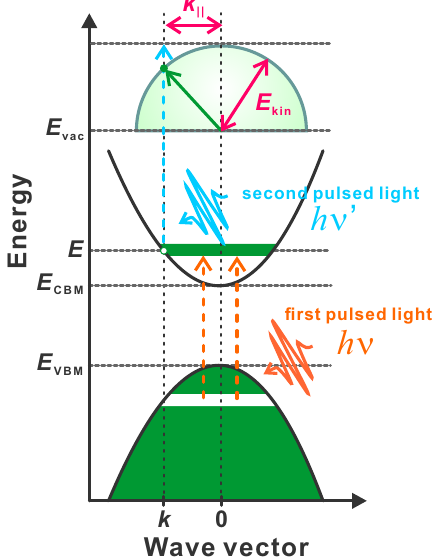
Figure 1. A schematic view of two-photon photo-emission process is shown. E VBM , E CBM and E vac represent the energies at the valence band maximum, conduction band minimum and vacuum level, respectively. E kin is the kinetic energy of the photo-emitted electron. k || is the wave vector (or momentum) of the photo-emitted electron parallel to the crystal surface. For more details, see the